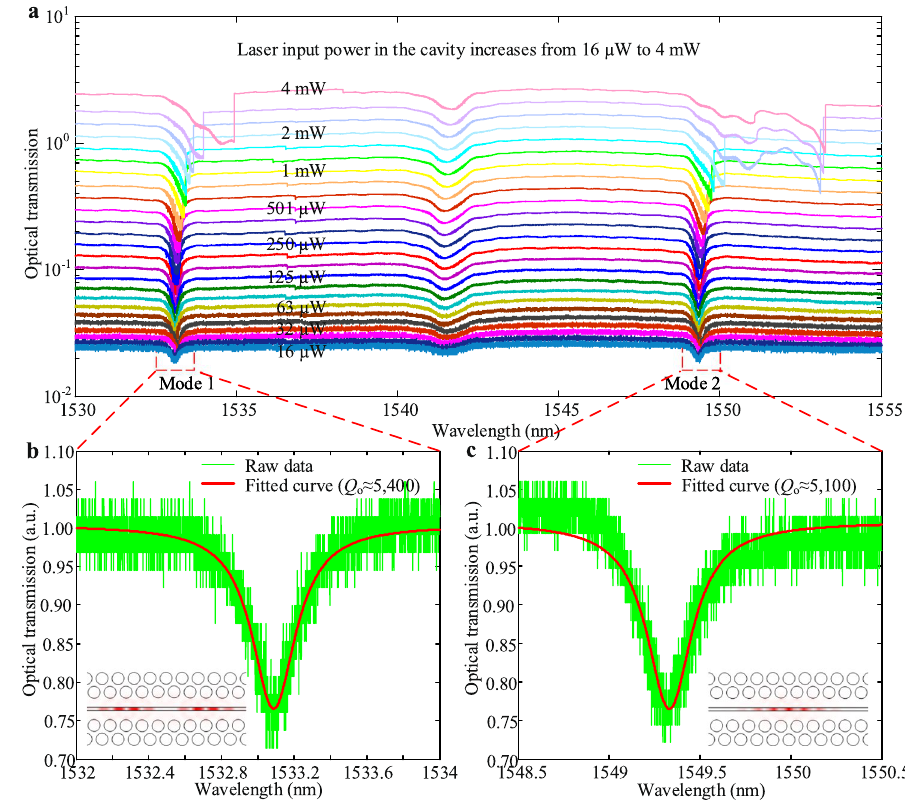
Figure 2. Optical transmission spectra of the optomechanical cavity. (a ) Optical transmission spectra under different input powers from 16 μ W to 4 mW. ( b and c ) Magnified plots for the two modes with the fitted loaded optical Q